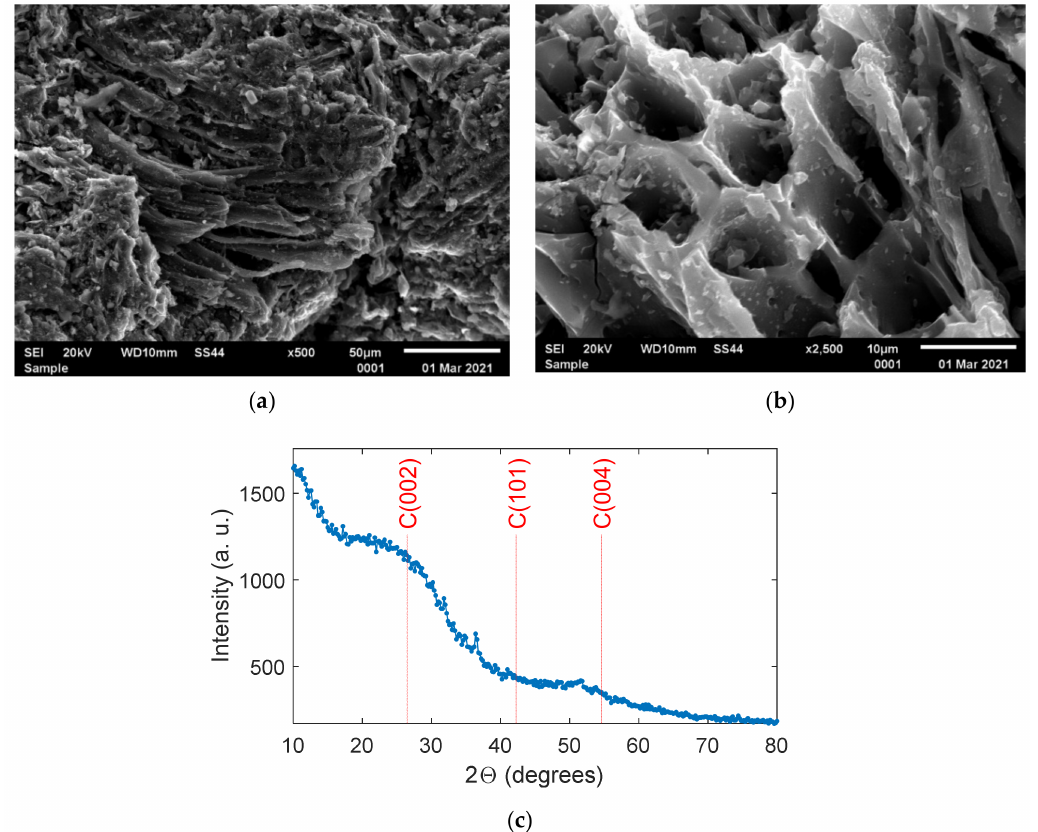
Figure 1. Scanning electron microscope (SEM) images of the sunflower husk biochar sample for: ( a ) × 500 and ( b ) × 2500 magnification. ( c ) Powder X-ray diffraction pattern of the biochar sample with marked the angular positions of graphite crystallographic planes reflections.